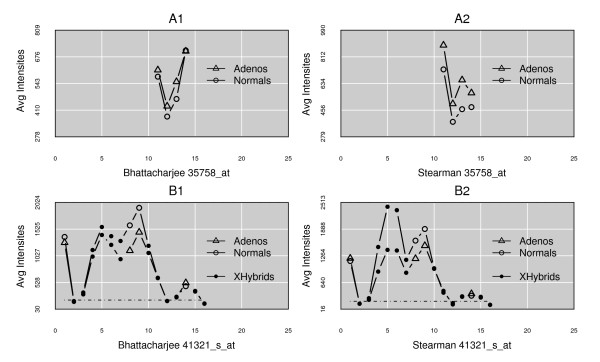
Response patterns for cross-hybridizing probes. The x-axis is the index of a probe within a ProbeSet; the y-axis is the mean intensity of a probe across the samples in a class. A1 and A2 show only cross-hybridizing probes for the two classes in each experiment. For a different gene, B1 and B2 show a complete set of probes, with filled circles indicating the cross-hybridizing probes. Cross-hybridizing probes are much less consistent in direction and extent of change between disease classes and across sample sets than the filtered probes (see Figure 5 for comparison).